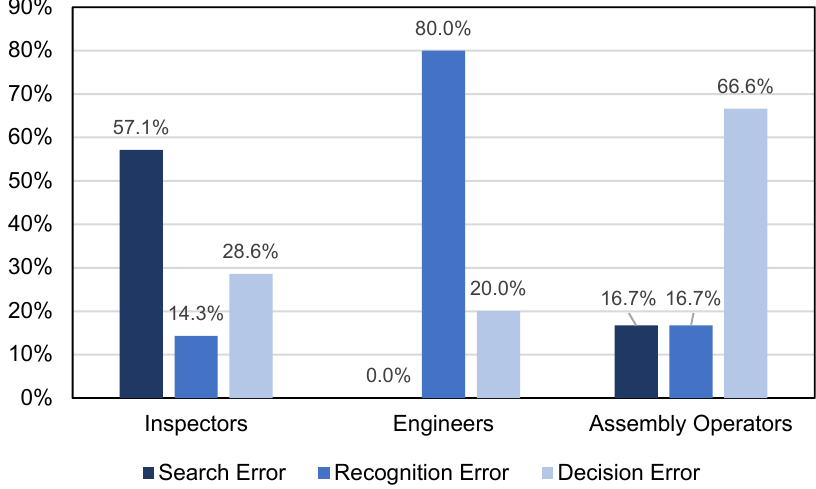
Figure 22. Distribution of inspection errors made by expertise group. The eye tracking data of the participants who missed the defect were further analysed, and heat maps and gaze plots were created for a representative sample of each group and for the predominant inspection error. The results are shown in Figure 23.